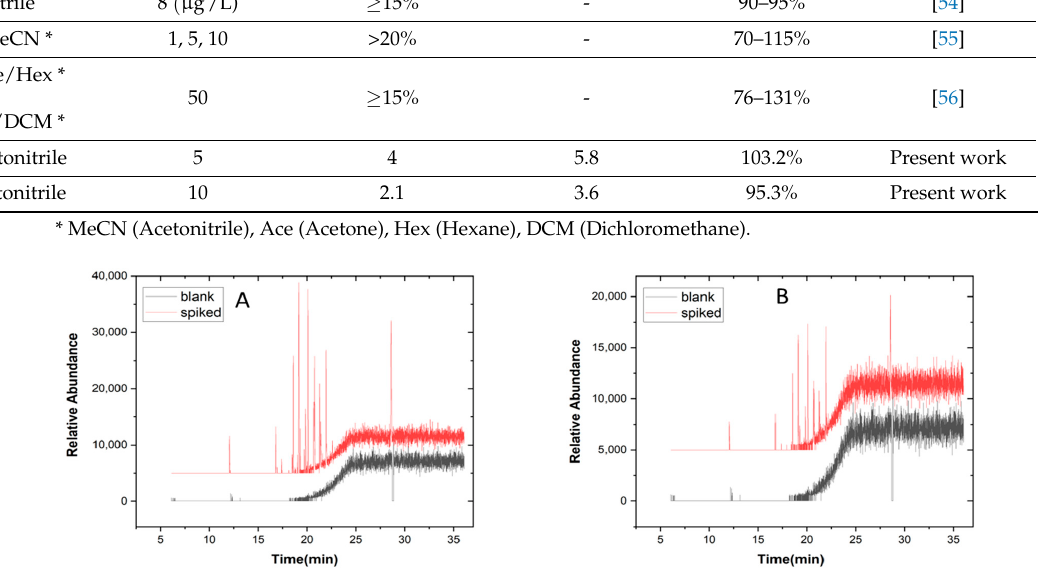
Figure 5. ( A ) GC/MS Total ion chromatogram of Aroclor 1254 (red line) and the blank (black line) for 10 µg /kg soil sample after QuEChERS extraction. ( B ) GC/MS Total ion chromatogram of Aroclor 1254 (red line) and the blank (black line) for 5 µg /kg soil sample after QuEChERS extraction. Table 1. Comparison of the present study with other studies. For the present work recovery and RSD was included at di ff erent Aroclor 1254 concentrations in soil samples (n = 3).